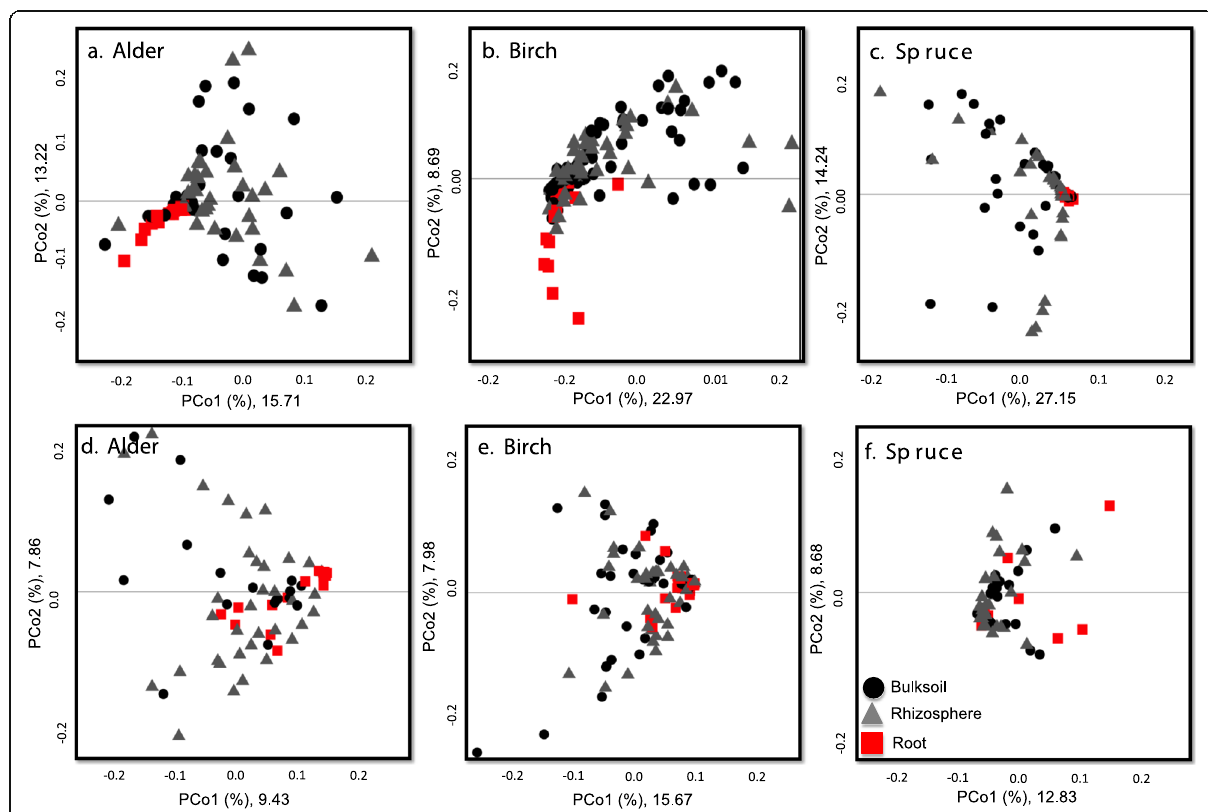
Fig. 3 a – c Principal coordinates analysis of bacterial communities associated with alder ( a ), birch ( b ), and spruce ( c ) in bulk soil, the rhizosphere, and roots. d – f Principal coordinates analysis of fungal communities associated with alder ( d ), birch ( e ), and spruce ( f ) in bulk soil, the rhizosphere, and